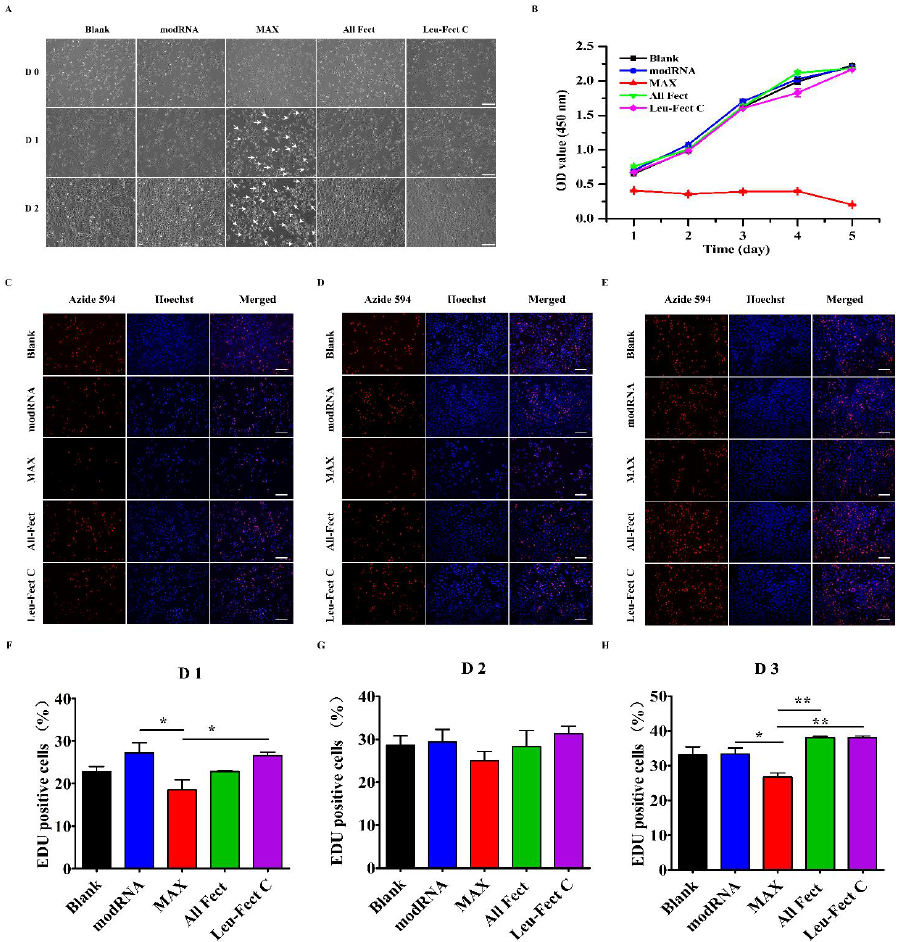
Figure 4. In vitro safety of lipopolymer vectors. ( A ) The morphology of cells after treatment with chosen vectors (scale bar: 200 μm). ( B ) Cellular proliferation after treatment with lipopolymer complexes at daily time intervals, as determined by the CCK-8 assay. Data represent mean ± SD ( n = 5). ( C – E ) EdU stained cells at different time points. EdU (red) and Hoechst (blue) show the nuclei of cells in the cell cycle and all nuclei, respectively (scale bar: 200 μm). ( F – H ) Quantitative analysis of EdU-positive cells at 1, 2 and 3 days. ( n = 5) (* p < 0.05, ** p < 0.01).